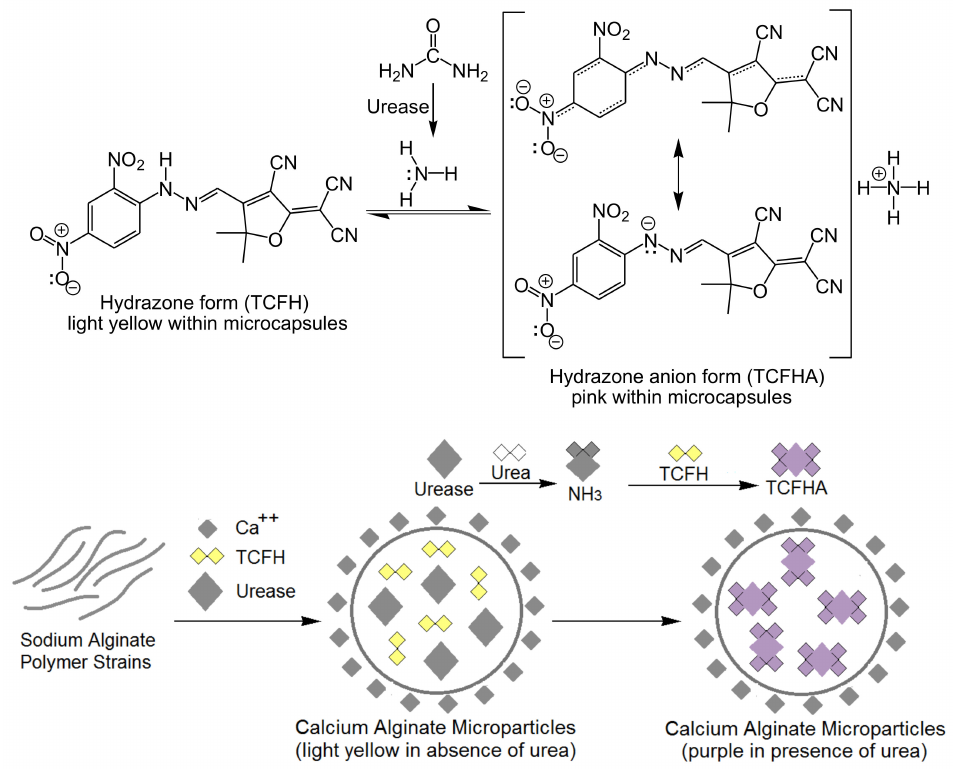
Figure 7. Proposed mechanism ( top ) and schematic diagram ( bottom ) for the colorimetric detection of urea using tricyanofuran-hydrazone active receptor sites; TCFH is tricyanofuran-hydrazone, TCFHA is tricyanofuran-hydrazone anion. “Reprinted with permission from Elsevier